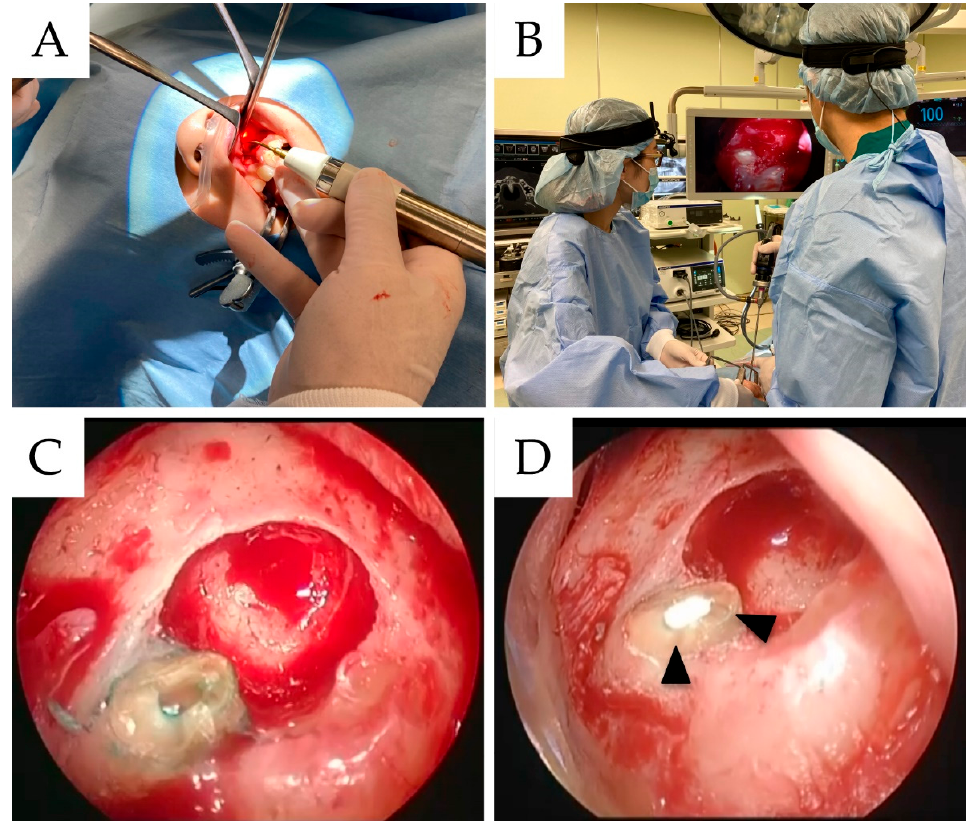
Figure 1. ( A ) The piezosurgery was used for root-end canal cleaning. ( B ) The image shows an endoscopic endodontic surgery. The surgical field of view magnified by the endoscope through the large screen monitor in the operating room is shown. ( C ) Confirmation of presence or absence of microcracks after staining with methylene blue. ( D ) MTA cement was filled in the root-end apex. (arrowhead: MTA